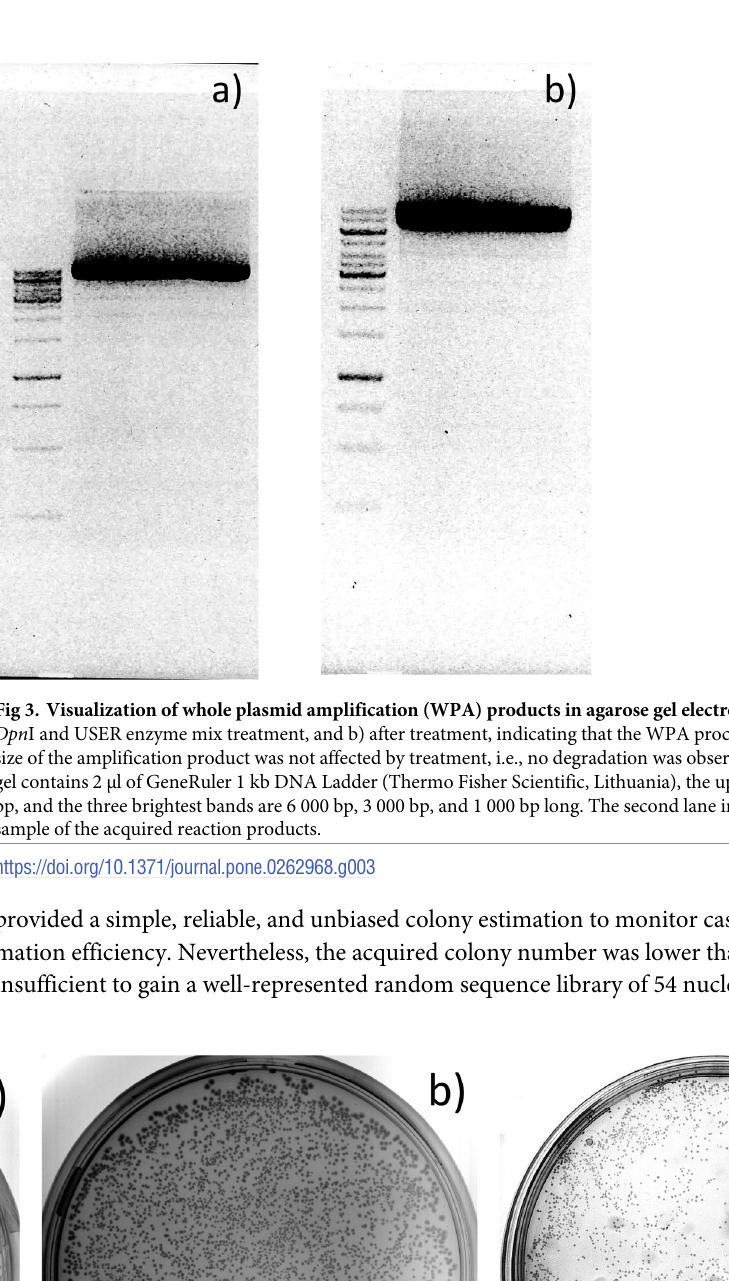
PLOS ONE | https://doi.org/10.1371/journal.pone.0262968 August 8,